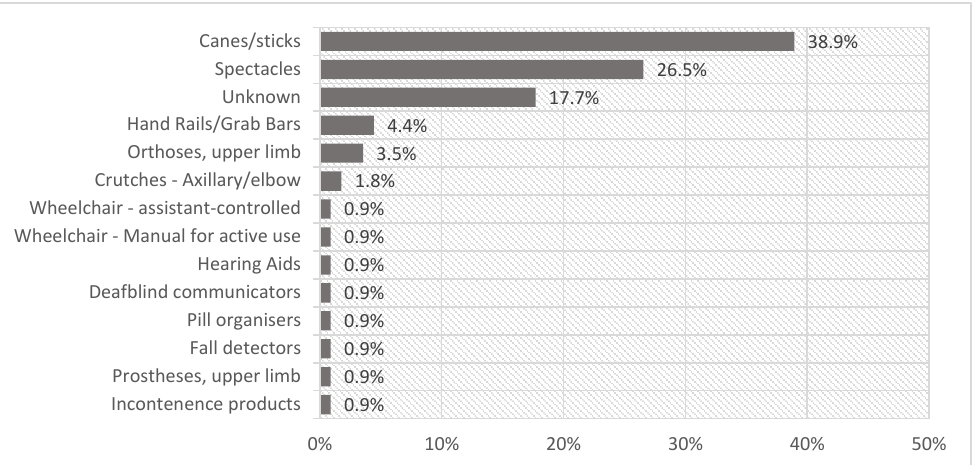
Figure 2. AP used by 112 persons with any difficulty in any domain. Unknown products are where participants identified any ‘other’ device for any domain but no further information was provided.